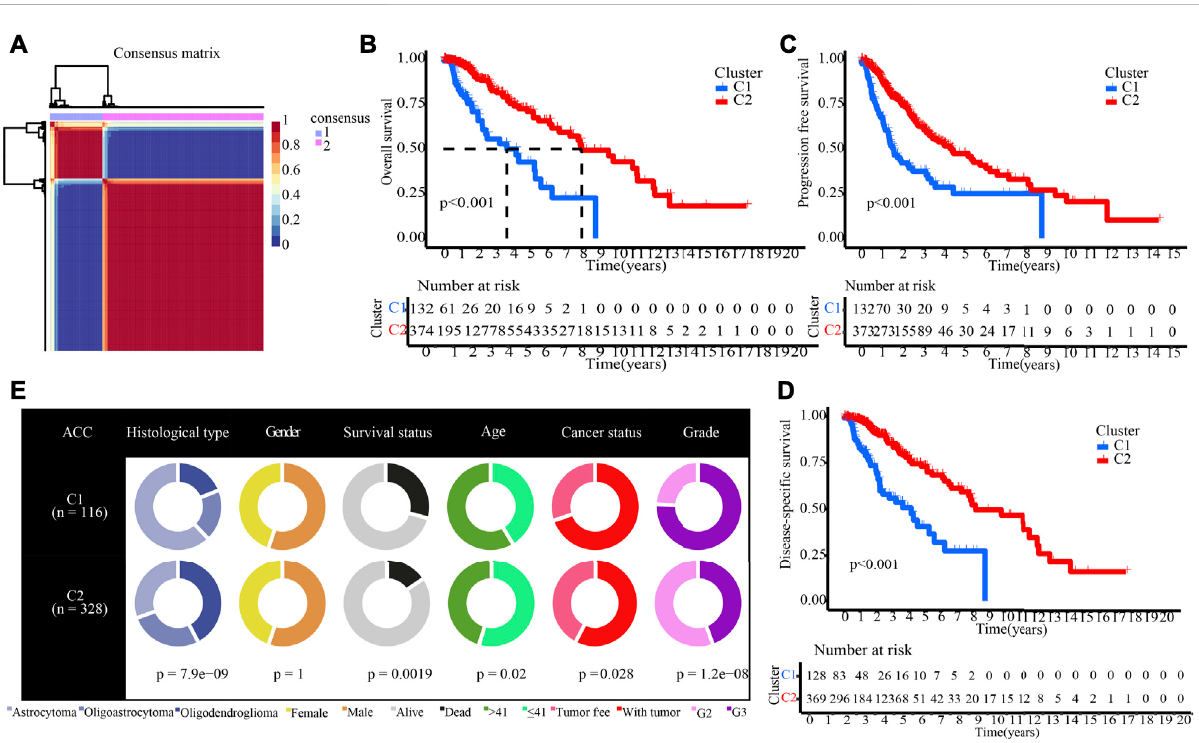
FIGURE 4 NMF clustering yields two molecular subtypes with signi fi cantly different prognoses and clinical characteristics. (A) The optimal clustering number of 2. (B – D) Kaplan-Meier analyses (OS, PFI, and DSS) as regards two molecular subtypes. (E) Pie charts illustrating the Chi-squared test of clinical and pathologic features between two molecular